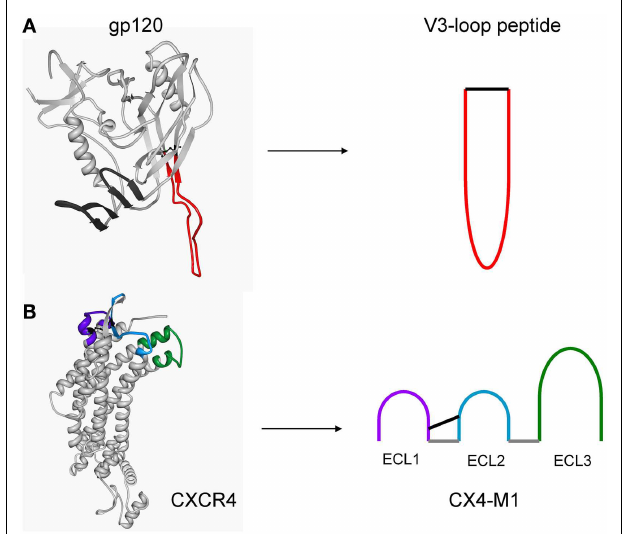
FIGURE 1 | Structure-based design of peptides presenting theV3 loop of gp120 (A), and the three extracellular loops of CXCR4 (CX4-M1) (B) . Peptides were designed based on crystal structures of a gp120–CD4 complex (pdb: 2b4c) and CXCR4 (pdb: 3odu),